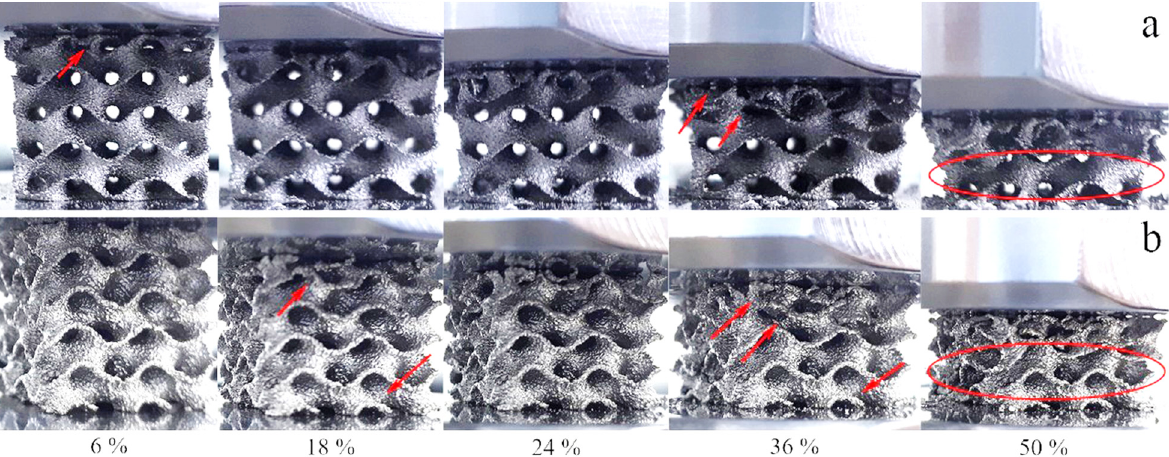
Figure 7. Steps of mechanical deformation during compression: ( a ) WT; ( b ) MT. Red arrows indicate places where the structure lost integrity during compression. The encircled layers keep integrity even at the 50% strain.